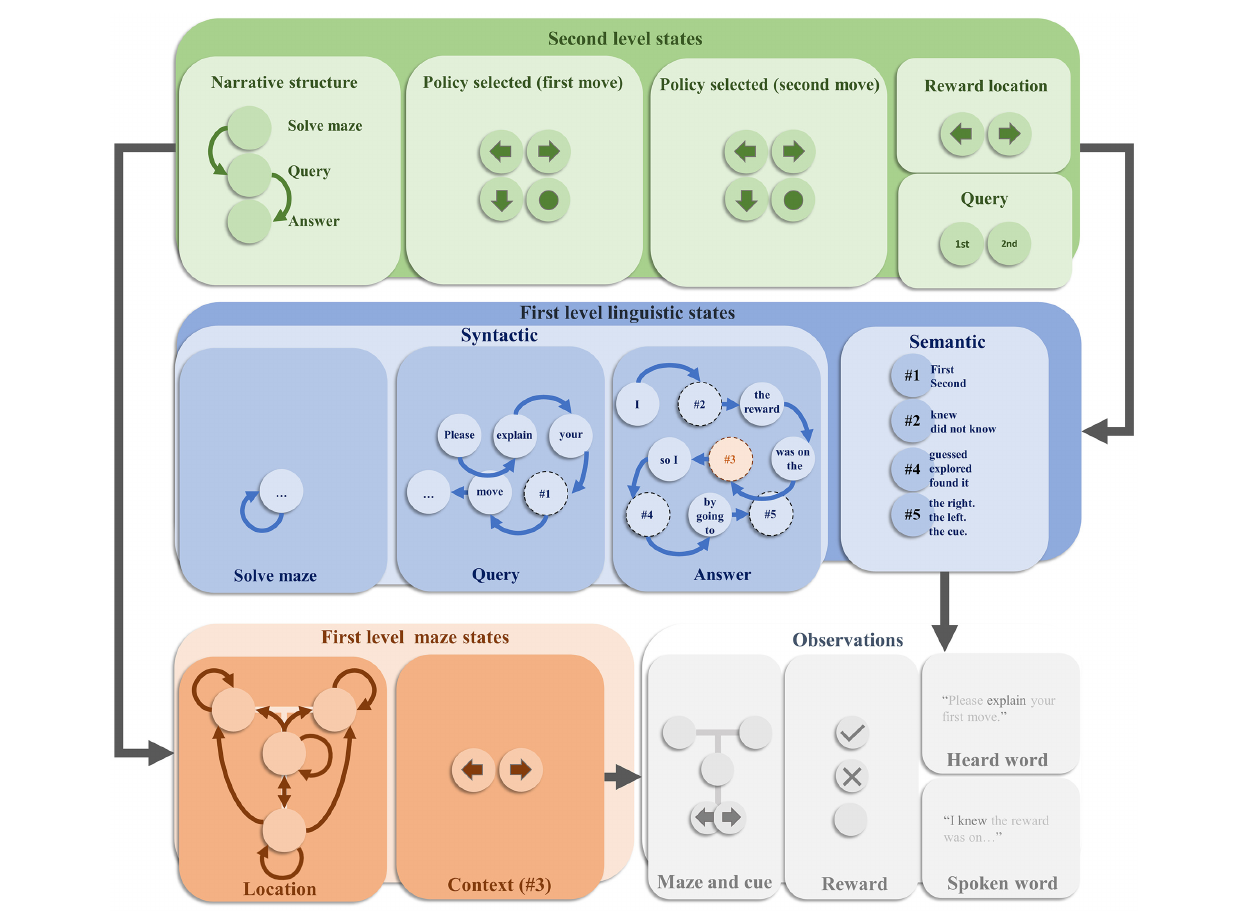
FIGURE 1 | The generative model . This schematic offers an overview of the internal model used by an agent to explain how hidden states conspire to generate observable outcomes. This figure is displayed in four main parts. These are the second level hidden states, the first level linguistic states, the first level maze states, and the observed outcomes. Each of these is further decomposed or factorised. The overall structure of the model means that second level states predict first level states. Although not shown here explicitly, the second level states additionally predict the policy (or trajectory) of the location states at the first level, providing a context sensitive bias for decision making. The first level states then combine to predict the observations. Arrows between states within each factor represent allowable transitions. In the absence of arrows, the assumption is that there are no dynamics associated with that state—i.e., it stays the same over time. Prior preferences are attributed to the outcomes such that the central location of the maze is mildly aversive. The reward outcome modality includes an attractive, aversive, and neutral outcome. Please see the main text for more